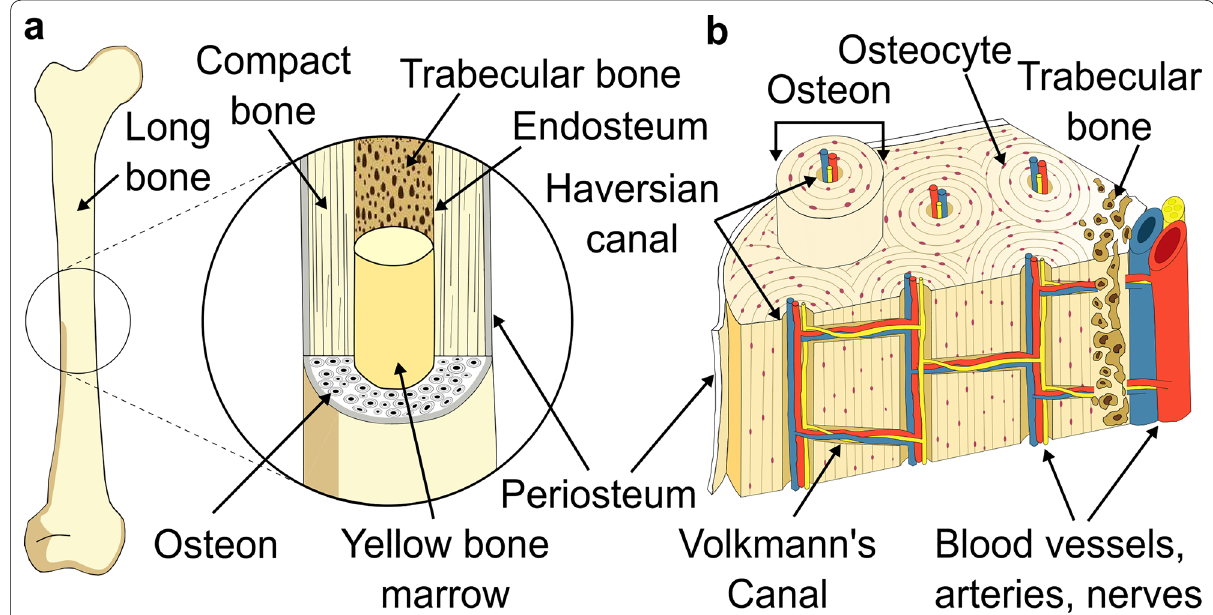
Figure 1 Schematic overview of the bone structure: ( a) a long bone possesses two main tissues, i.e., cortical bone in the outermost region and trabecular bone in the innermost region, which encloses the yellow bone marrow, ( b) the cortical bone microstructure consists of osteons that run along the principal loading direction of the bone and are immersed in the interstitial lamellae. Inside the cortical tissue two main porosity systems (Haversian and Volkmann’s) carry the necessary blood vessels and nerves for maintaining a healthy tissue. The osteocytes (shown as purple dots) are the cells that monitor the metabolism and remodelling process of the tissue. Schematic adapted from Ref.